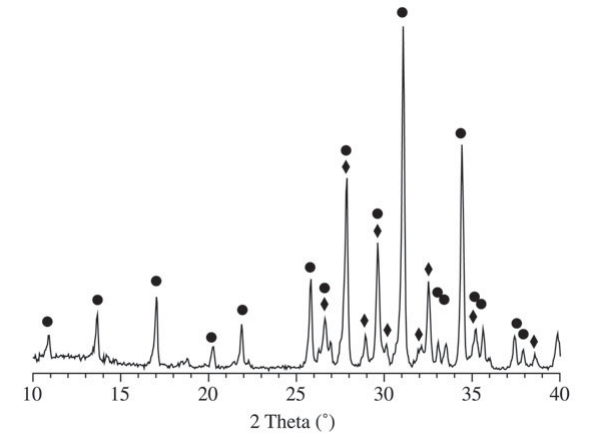
Figure 1. X-ray powder diffraction pattern of the starting β -TCP pow- der (fine). (cid:122) : β -TCP (JCPDF 9-169); (cid:141) : Ca